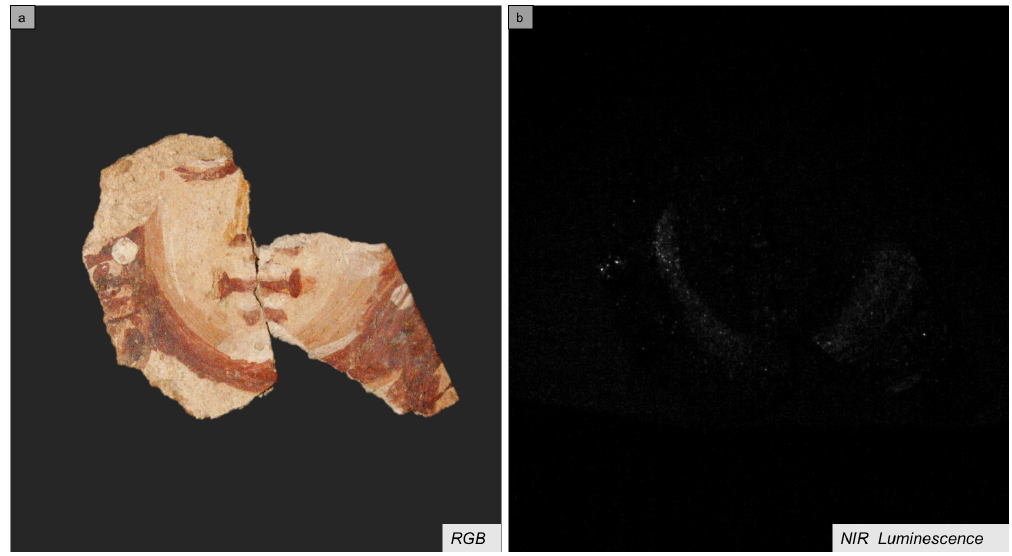
Figure 22. ( a ) A color (RGB) image of a reconstructed face from the painting fragments recovered in the tomb in the Costis Palamas square (H2); ( b ) Forensic imaging shows near-infrared (NIR) luminescence of Egyptian blue in the cheeks, indicating a mixture of Egyptian blue with white pigments to facilitate brighter tones in the shading of the